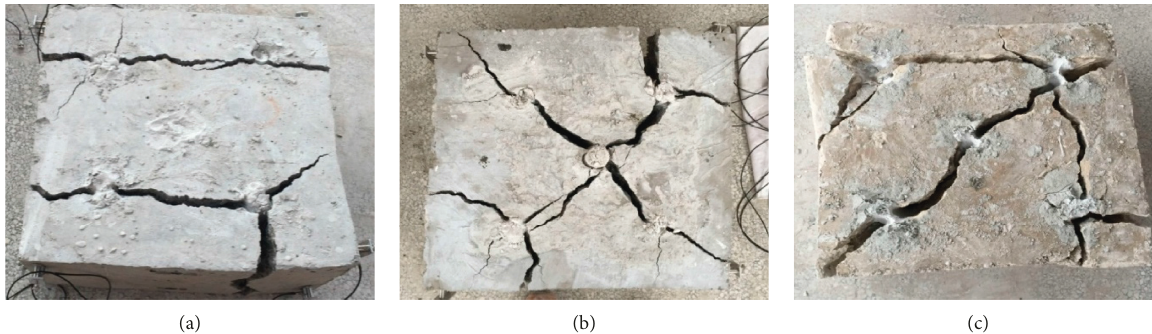
Figure 7: The fracturing observed in the test blocks: (a) C40; (b) C40-C10-C40; (c) layered concrete.